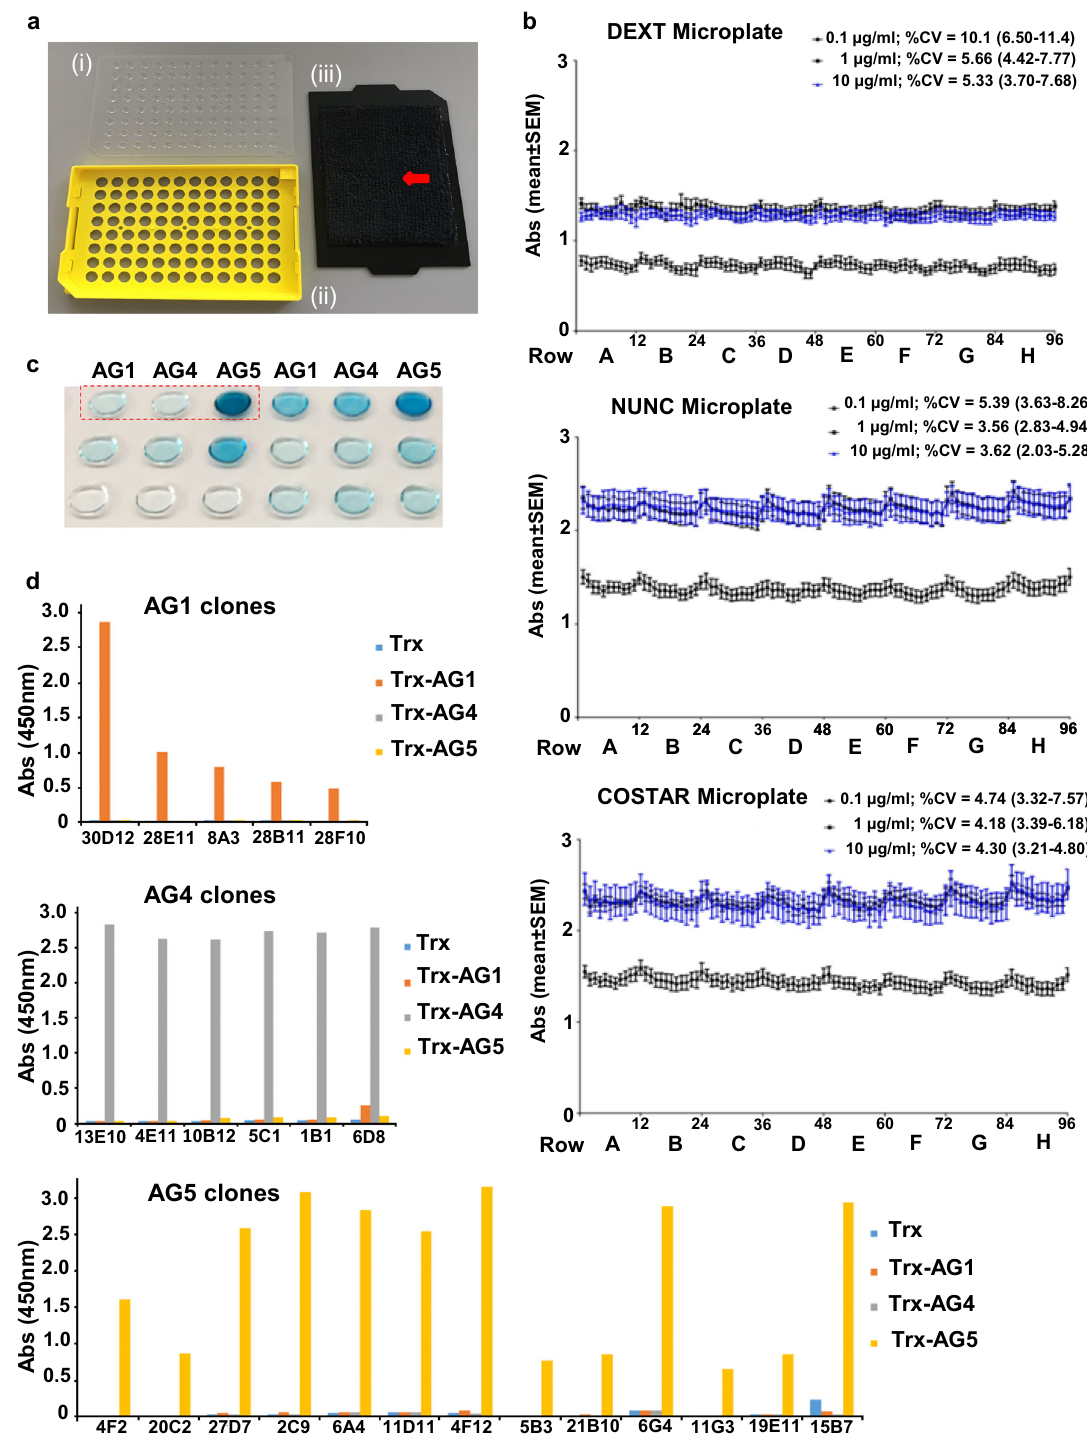
residues that are critical for antigen – antibody binding [Table 1; Supplementary Fig. 4]. Since short antigen sequences are used, only a small library of 54 peptides (including the three